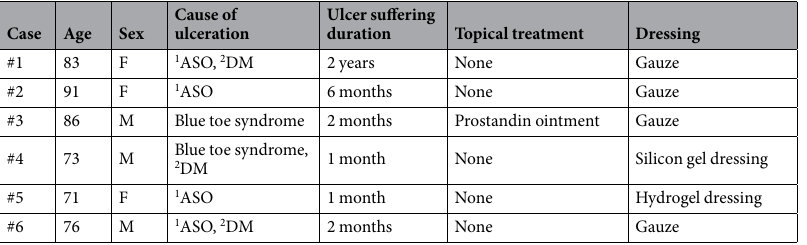
Table 1. Patient characteristics. 1 ASO: atherosclerosis obliterans, 2 DM: diabetes